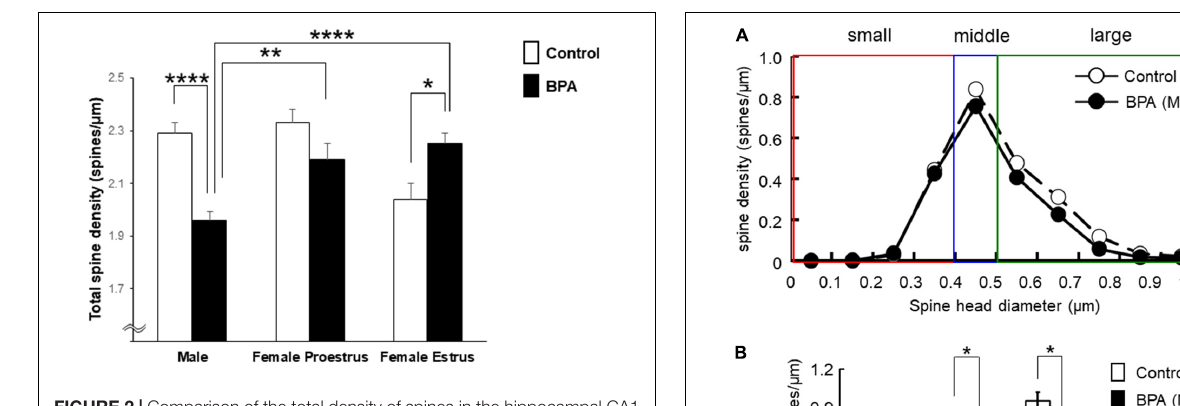
FIGURE 2 | Comparison of the total density of spines in the hippocampal CA1 neurons of grownup male and female rats after perinatal BPA exposure. Results are represented as mean ± SEM. In each group, the white and black columns express the control and BPA-exposure data, respectively. We investigated 6 rats, 13 slices, 25 neurons, 50 dendrites, ∼ 5700 spines for male control; 8 rats, 13 slices, 26 neurons, 51 dendrites, ∼ 5000 spines for male BPA; 3 rats, 7 slices, 13 neurons, 26 dendrites, ∼ 3000 spines for female proestrus control; 4 rats, 8 slices, 16 neurons, 32 dendrites, ∼ 3500 spines for female proestrus BPA; 3 rats, 8 slices, 16 neurons, 31 dendrites, ∼ 3200 spines for female estrus control; and 6 rats, 15 slices, 30 neurons, 60 dendrites, ∼ 6800 spines for female estrus BPA. Statistical analysis was performed with two-way ANOVA followed by Tukey–Kramer multiple comparison test. Statistical significance yielded * p < 0.05, ** p < 0.01, and **** p < 0.001. For two-way ANOVA, two factors include BPA (control, BPA) and sex categories (male, female proestrus, and female estrus).